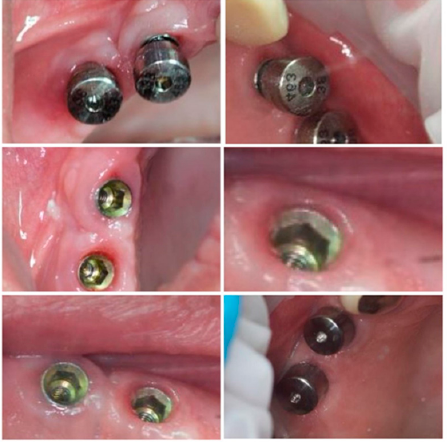
Figure 8. Magdent ™ pulse electromagnetic healing caps in position. Figure 8. Magdent™ pulse electromagnetic healing caps in position. Figure 8. Magdent™ pulse electromagnetic healing caps in